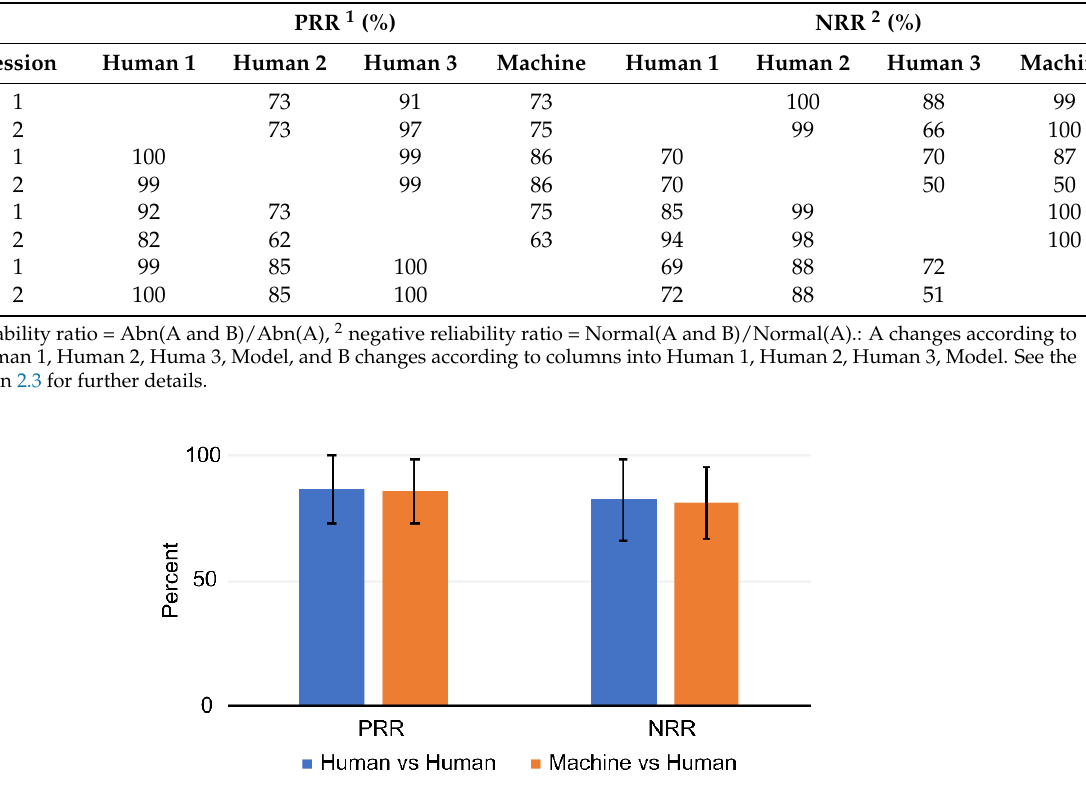
Figure 3. PRR and NRR values averaged between human raters and between machine and human raters.